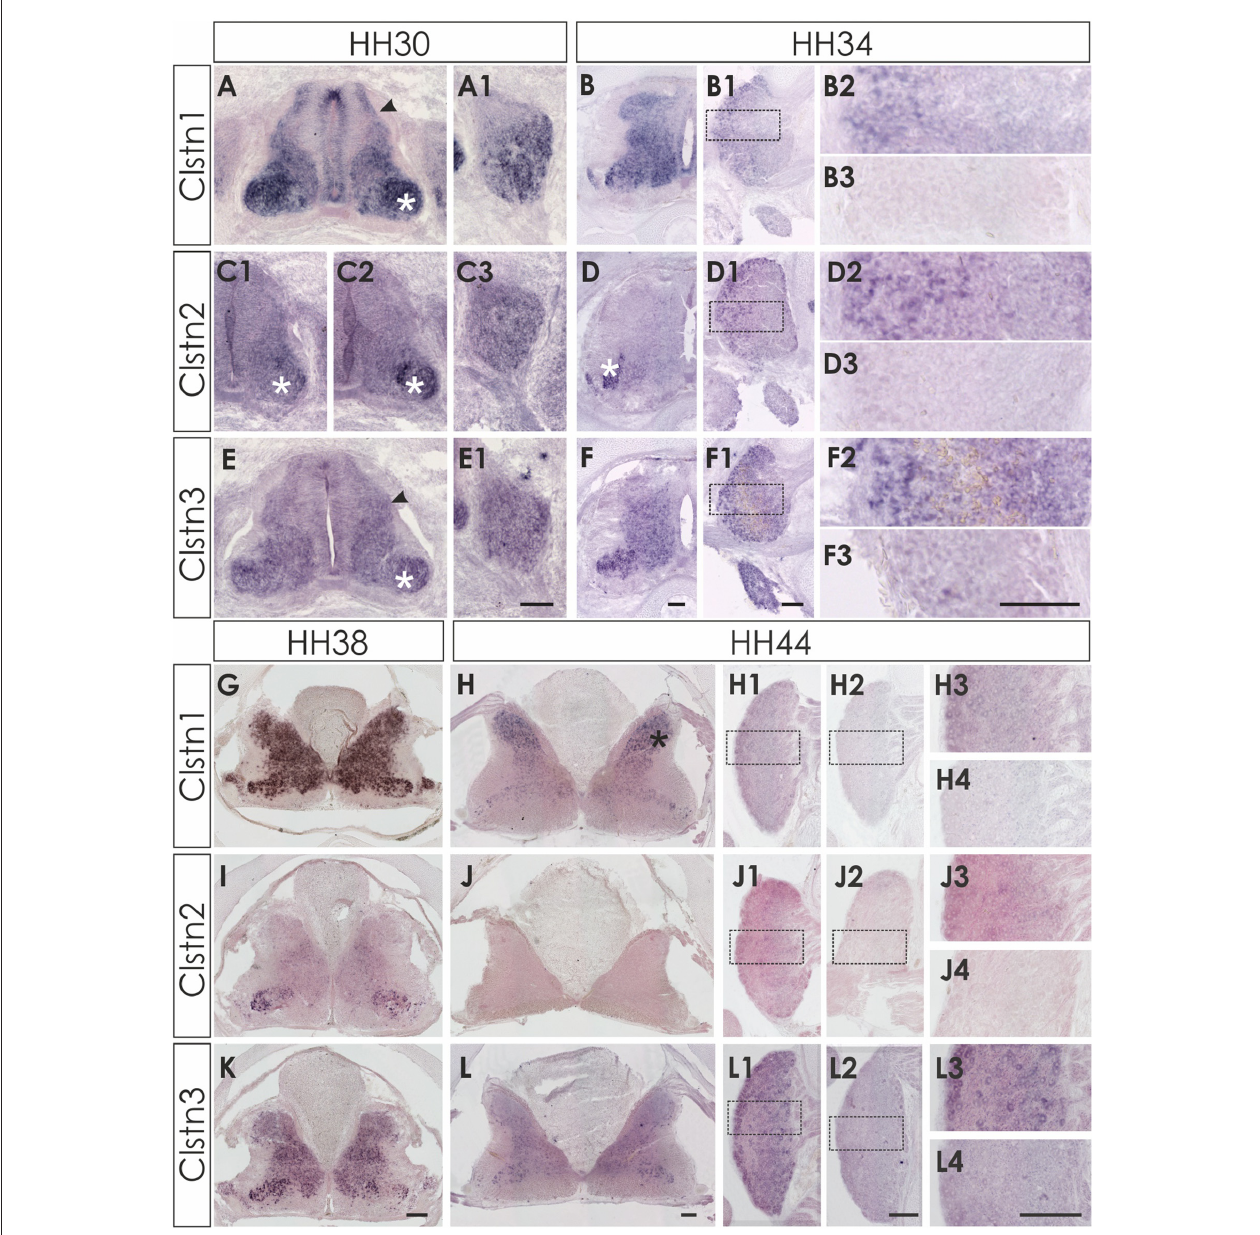
FIGURE 2 | Expression of Clstn1, 2 and 3 mRNA in late spinal cord development (HH30-HH44). The expression of Clstn1 (A,B,G,H) , Clstn2 (C1,C2,D,I,J) and Clstn3 (E,F,K,L) persisted throughout development of the spinal cord. The expression of Clstn1 mRNA at HH30 (A) was very similar to HH24. Relative levels changed, as expression levels in motoneurons (white asterisk) were higher than in interneurons (black arrowhead; compare to HH24 in Figure 1 ). In DRG, Clstn1 mRNA is restricted to the ventro-lateral part (A1) . This does not change by HH34 (B1,B2) . Expression of Clstn1 in the spinal cord is ubiquitous at HH34 (B) and at HH38 (G) . By HH44, Clstn1 is expressed predominantly in the dorsal horn ( H ; black asterisk). In DRG, expression is still found in the lateral part (H1,H3) . Clstn2 expression in the spinal cord is mainly restricted to motoneurons at HH30 ( C1,C2 ; white asterisk). Expression is motoneuron pool-specific and, thus, changed markedly along the rostro-caudal axis ( C2 is more rostral than C1 ). Expression of Clstn2 in DRG is more widespread than Clstn1 at HH30 (C3) . With increasing age, the signal is more pronounced in the lateral part (D1,D2) . Expression in the spinal cord is still mainly restricted to motoneurons ( D ; white asterisk). This does not change at HH38 (I) . However, at HH44 Clstn2 was no longer detected in the spinal cord (J) . Similarly, only few cell in the DRG still express Clstn2 at this stage (J1,J3) . Clstn3 expression at HH30 (E) is similar to HH24 with higher levels of expression in motoneurons (white asterisk) compared to interneurons (black arrowhead). In DRG, Clstn3 is expressed in cells scattered throughout the ganglion at HH30 (E1) , HH34 (F1,F2) and even at HH44 (L1,L3) . In the spinal cord Clstn3 expression was found ubiquitously at HH34 (F) , HH38 (K) and HH44 (L) , although expression levels are higher in the ventral horn. Sections shown in (B3,D3,F3,H2,H4,J2,J4,L2,L4) were processed with the respective sense probes. Higher magnification images were taken from the area outlined in (B1,D1,F1,H1,J1,L1) . Bar: (A1–F3) 100 µ m; (G–L4) 200 µ